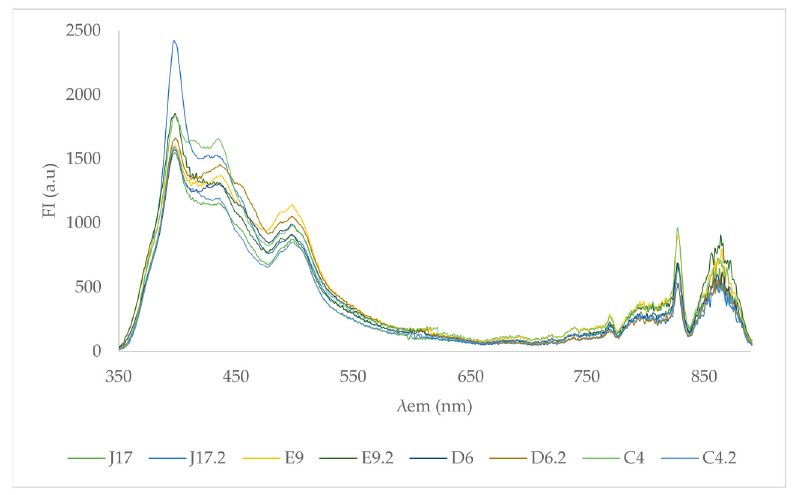
Figure 2. The emission spectra between for stored and fresh beer samples (J17 vs. J17.2, E9 vs. E9.2, D9 vs. D9.2 and C6 vs. C6.2).